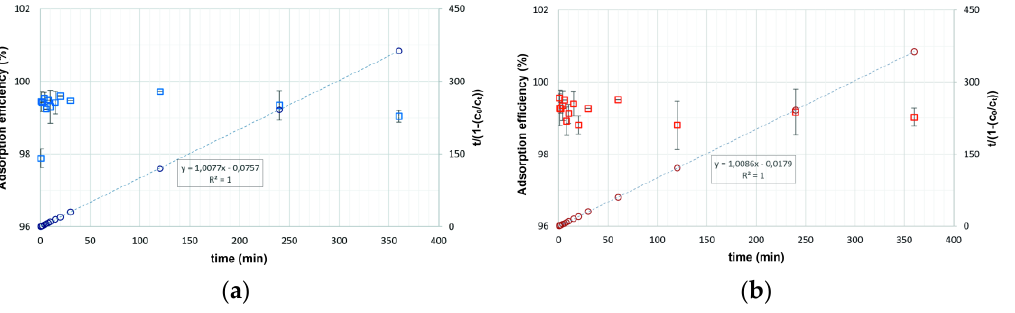
Table 6. Values of the correlation coefficient (R 2 ) for the kinetic models used. Kinetic Model